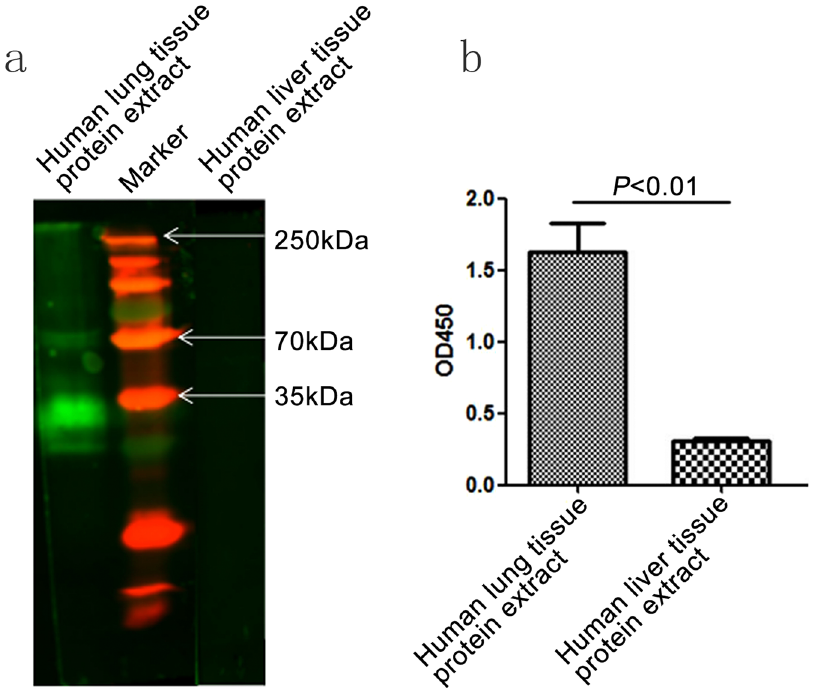
Figure 1. Human pulmonary tissues expressed abundant SP-A protein. ( a ) Representative image of Western blot for human pulmonary SP-A protein. Human pulmonary frozen tissues and human liver tissues were homogenized. Total proteins were extracted, separated (50 µ g) on SDS-PAGE gel, and transferred to a PVDF membrane. The membrane was probed with the primary mouse anti-human SP-A monoclonal antibody (SP- A-mAb) and the secondary anti-mouse IgG-FITC antibody. ( b ) ELISA assay to detect human pulmonary SP-A protein. Human tissue protein extracts were added to 96-well plates, and the plates were incubated with SP-A- mAb and secondary antibodies. The absorbance at 450 nm (OD450) was determined in a microplate